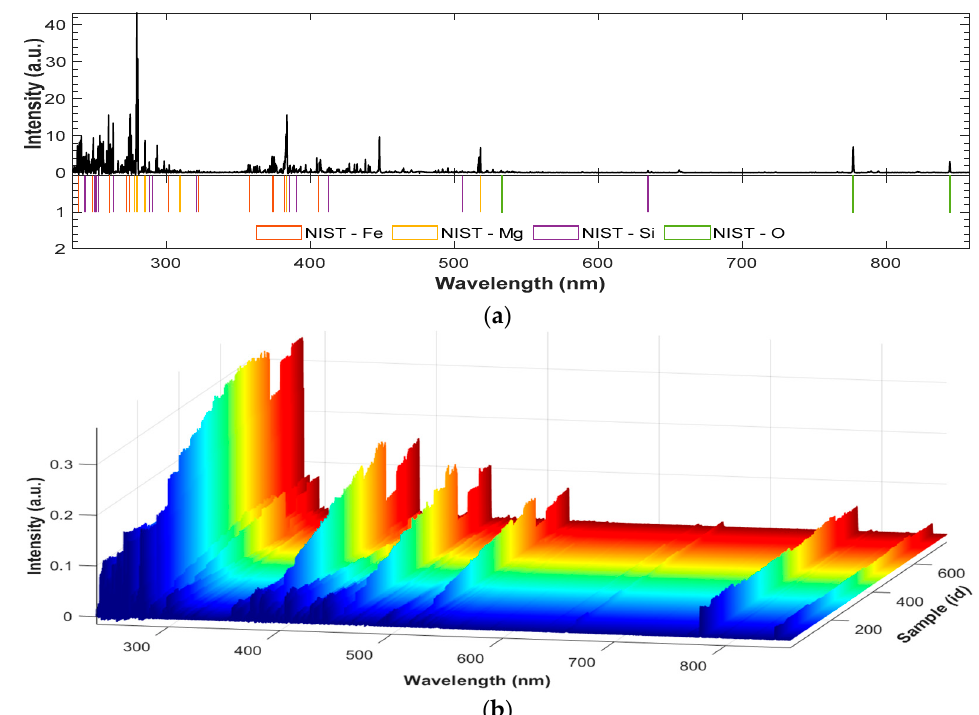
Figure 6. Elemental characteristic lines and normalized spectra of the 14 samples : ( a ) mean spectra of sample A-06 and the characteristic lines of elements (label in mean spectrum of Sample-A06); ( b ) all the normalized spectra of 14 samples (58 spectra per sample).